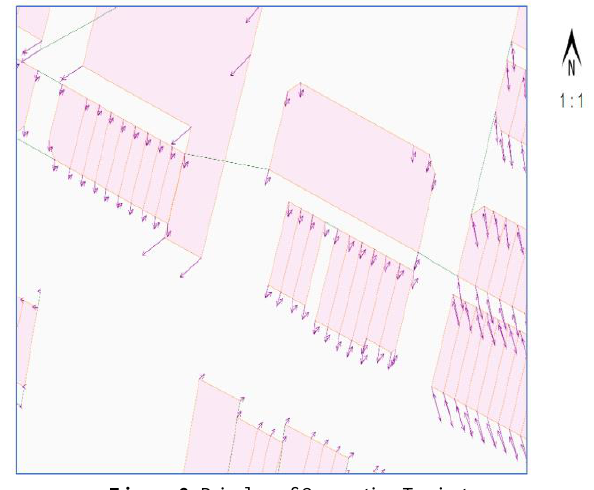
Figure 9. Display of Correction Trajectory